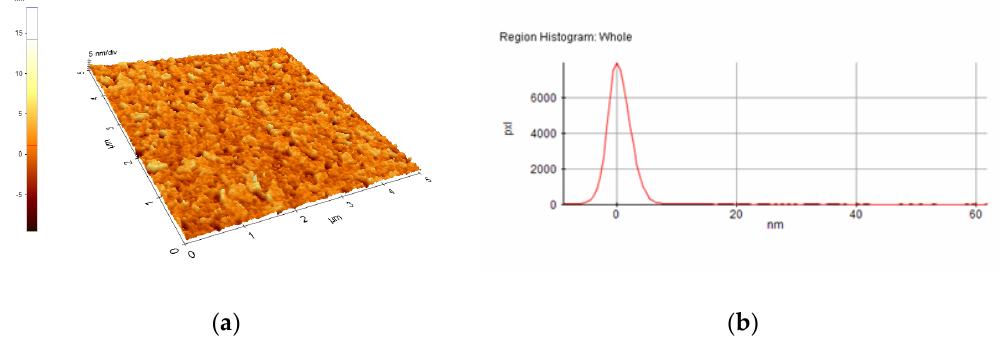
Figure 6. AFM image of 1.1%rGO-SiO 2 /glass film: ( a ) morphology, ( b ) region histogram.